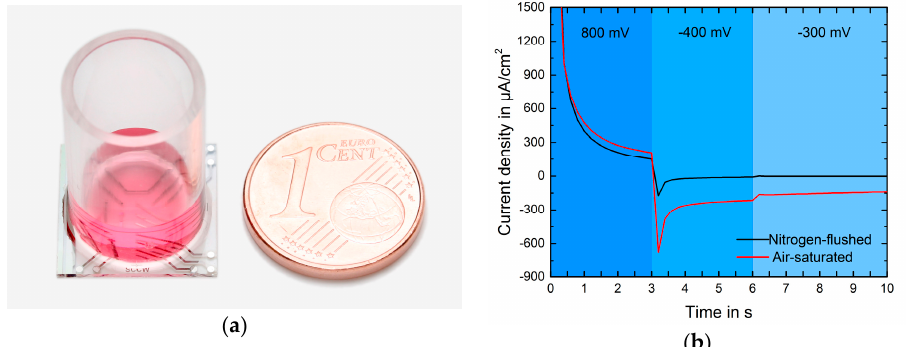
Figure 1. ( a )Transparent electrochemical sensor chip with cell culture well (transparent plastic cylinder); ( b ) Current response of one cycle. The 3-step protocol enables cleaning of the electrode surface.